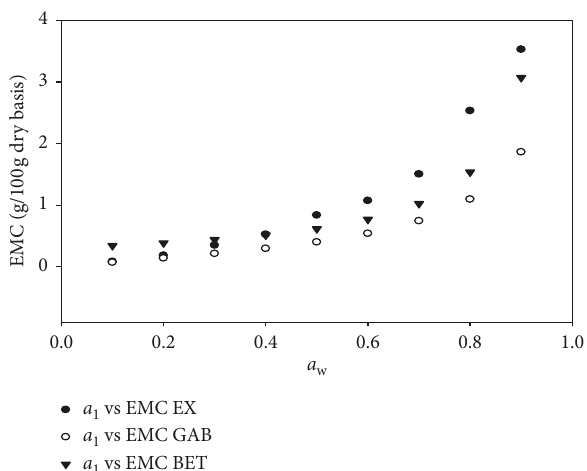
Figure 4: Comparison between experimental, GAB, and BET isotherms of millet flour resin (2% zinc chloride) at 40 °